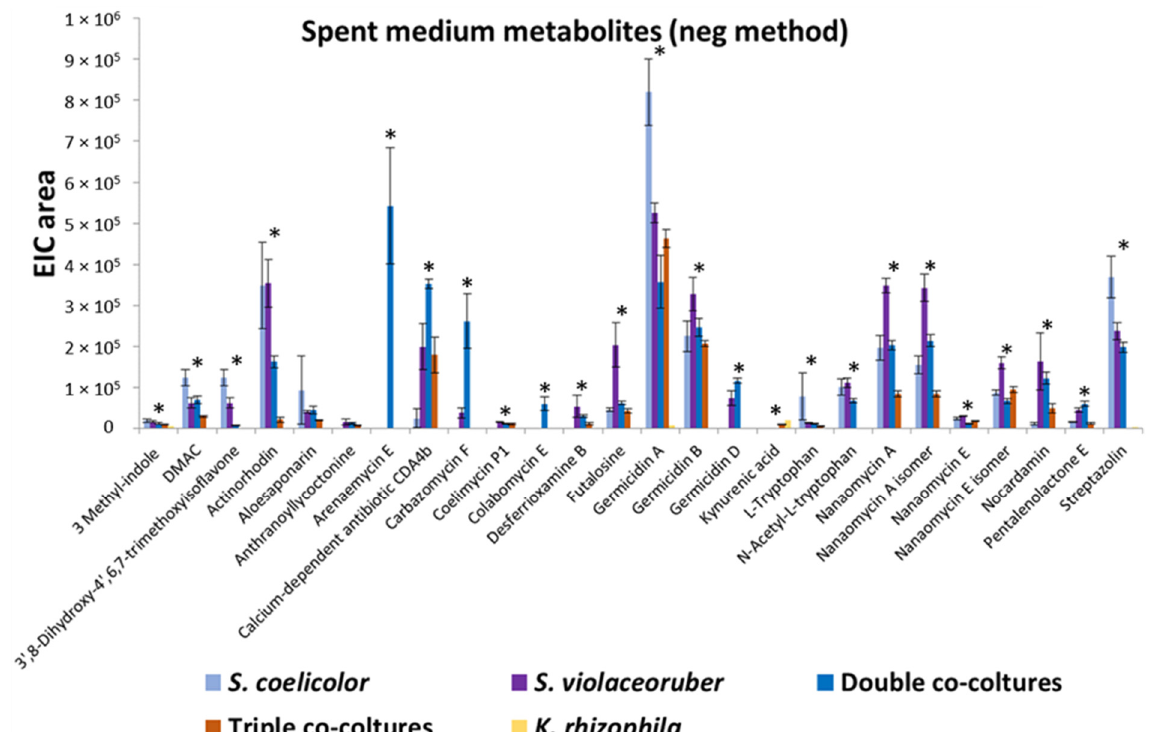
Figure 1. Quantitative profiles of extracellular metabolites reported as extracted ion chromatogram (EIC) area and identified in K. rhizophila, S. coelicolor, and S. violaceoruber cultivations, in S. coelicolor and S. violaceoruber (double) co ‐ cultures, and in S. coelicolor , S. violaceoruber, and K. rhizophila (triple) co ‐ cultures. The values are reported as the mean of three cultivations; SE values are also reported as bars. Asterisks indicate quantitative group differences that are statistically significant ( p < 0.05) according to the one ‐ way ANOVA test. Table 2. Metabolites identified using HPLC/MS/ESI/Q ‐ TOF from spent media of bacterial cultiva ‐ tions and their occurrence in different conditions.